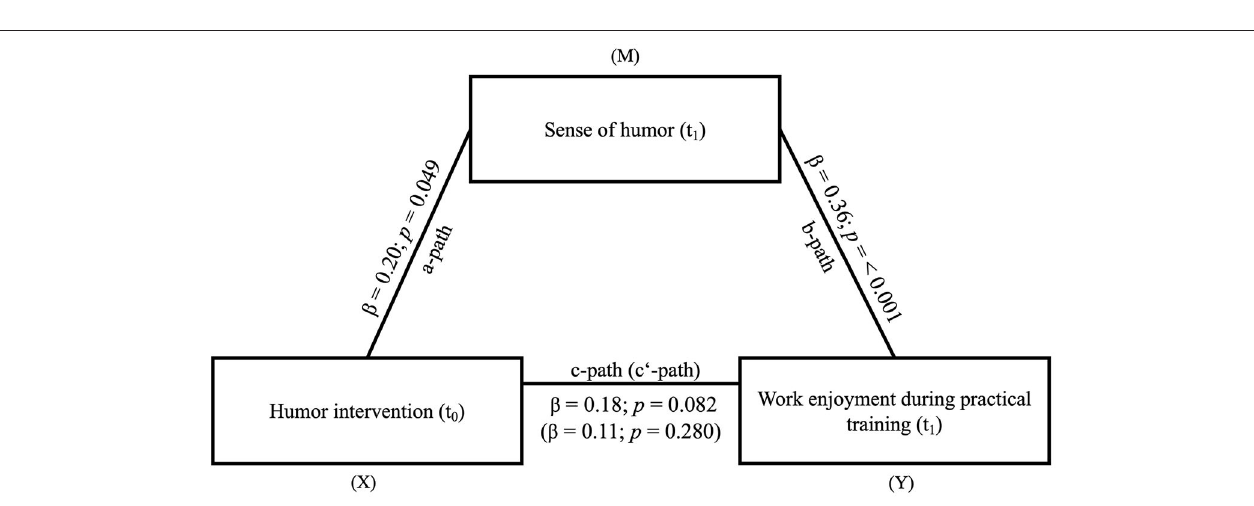
FIGURE 5 | Mediation model of the effect of the humor intervention (X) on work enjoyment during practical training (Y) via sense of humor (M). N = 94. The indirect effect from (X = independent variable) to (Y = dependent variable) via (M = mediator) was significant ( β = 0.07, SE = 0.04, 0.01 < CI < 0.15); Measuring points: t 0 = Baseline; t 1 = 6 months after the humor